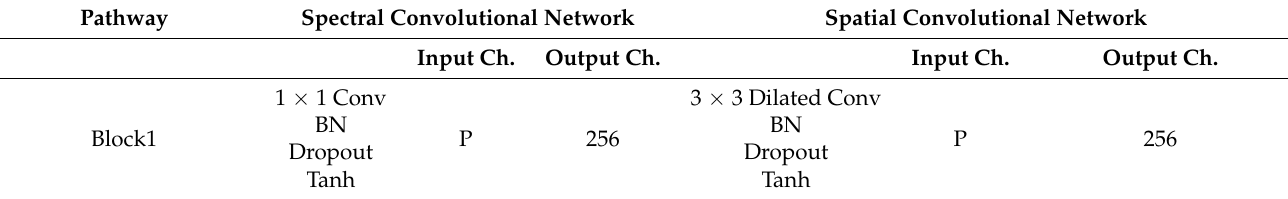
Table 2. Network structure of